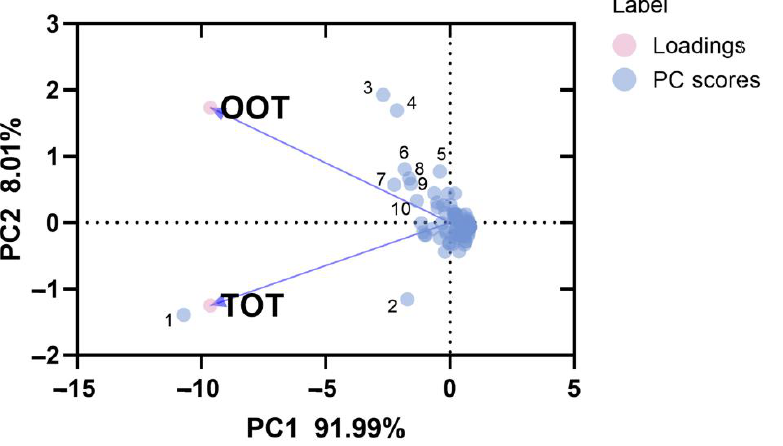
Figure 4. PCA biplot of volatile substance of TOT and OOT. Each point represents a volatile substance: 1, hotrienol; 2, benzyl alcohol; 3, nerolidol; 4, α -farnesene; 5, 1,3,5,7-cyclooctatetraene; 6, linalool; 7, β -ocimene; 8, β -myrcene; 9, indole; 10, linalool oxide III.